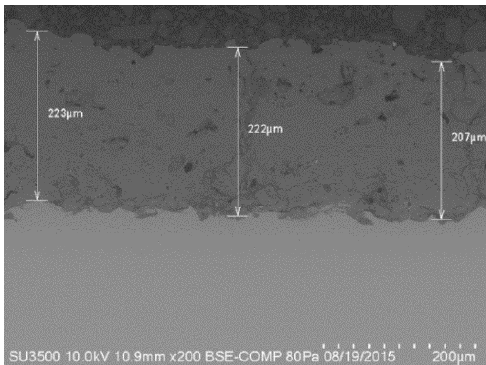
Figure 5. Transversal section from SEM showing thickness of the coating.